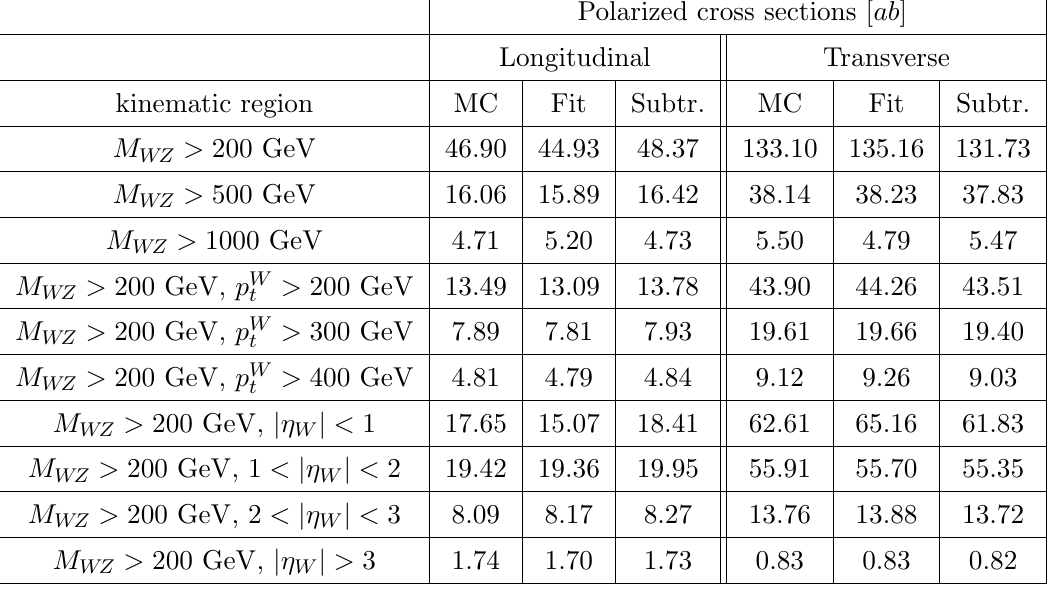
Table 17 . Cross sections ( ab ), for a longitudinal and transverse W + in W + Z scattering, in the Higgsless model, in several kinematic regions: comparison of MC predictions for the Higgsless model with results obtained via (cid:12)t and subtraction procedure. The subtraction procedure results for a transverse W + coincide with the SM cross